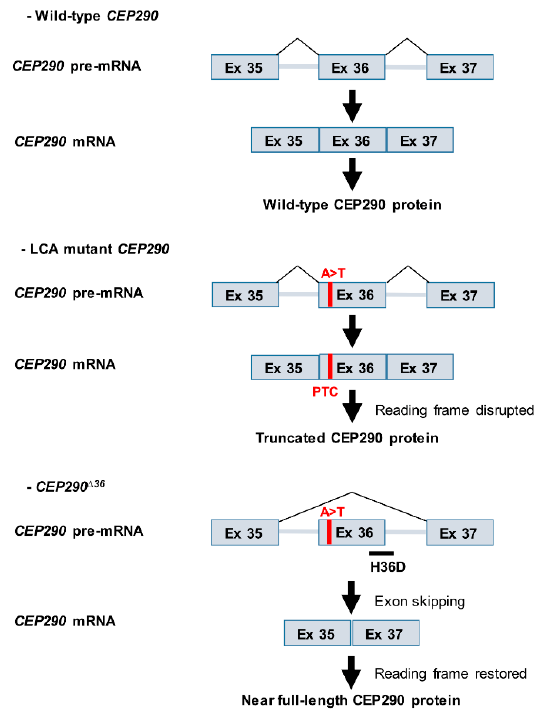
Figure 6. Antisense oligonucleotides (AONs)-mediated splicing alteration of CEP290 pre-mRNA to bypass protein truncation. An exonic mutation in CEP290 pre-mRNA (c.4723A > T, in red) introduces a PTC within exon 36 to CEP290 mRNA. Administration of AON (in black), targeting the splice donor site (H36D), is predicted to alter splicing by blocking the recognition of exon 36. Exclusion of exon 36 ( CEP290 ∆ 36 ) should allow bypassing protein truncation while maintaining the reading frame, and lead to the production of near full-length CEP290 protein.